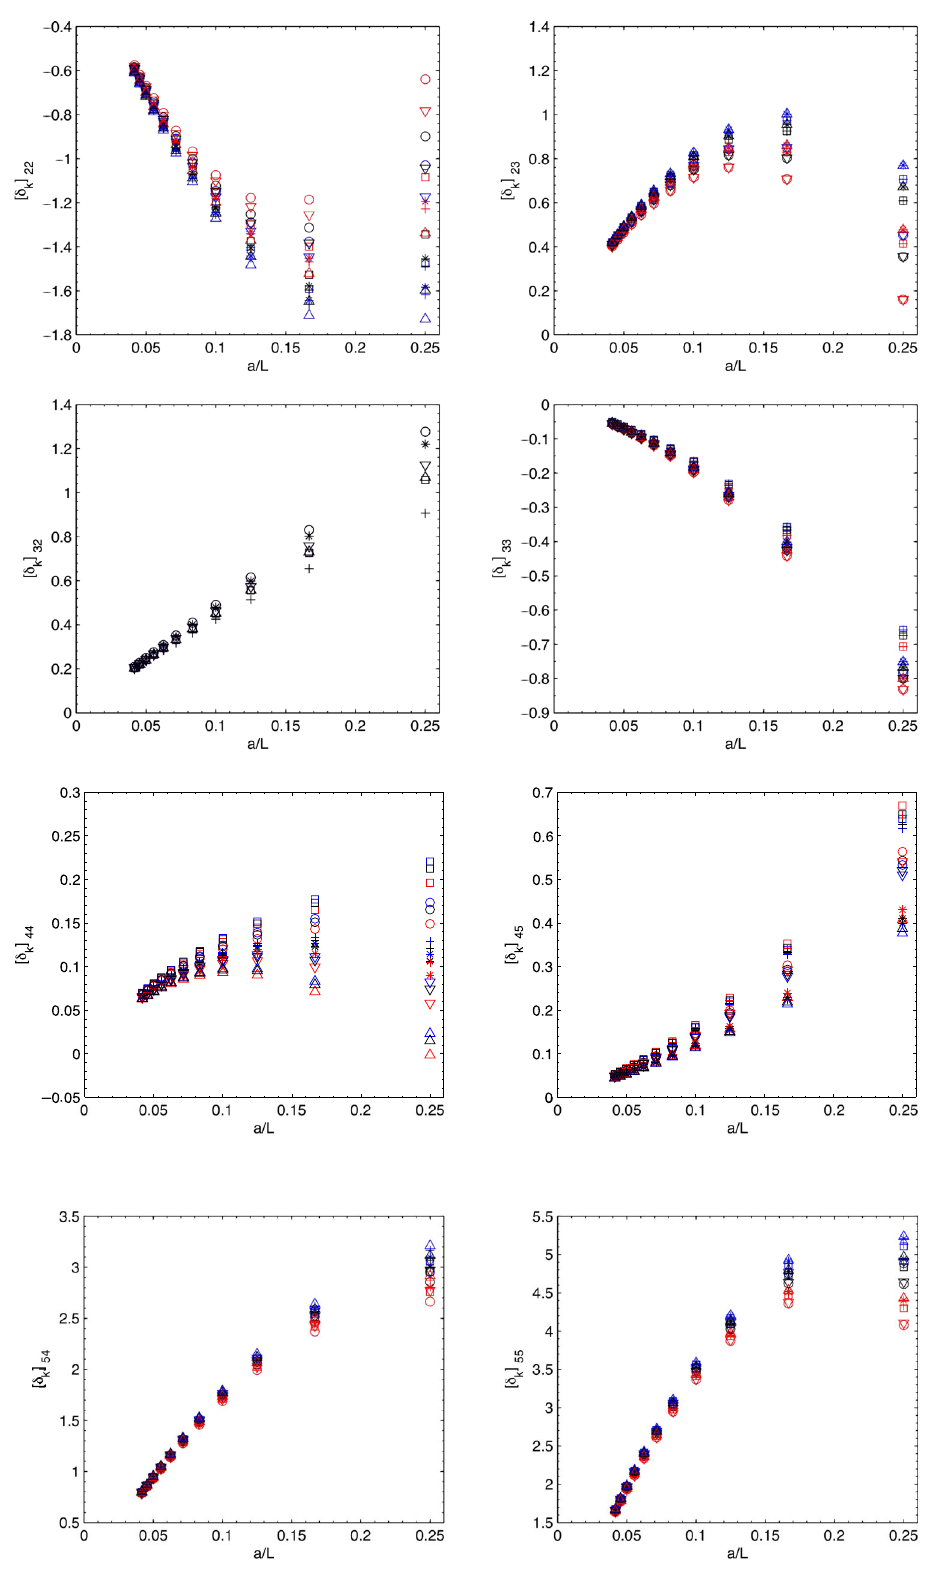
Fig. 17 Matrix elements of δ ( L / a ) with c = 0 for the k sw , Q − } (top) operator bases { Q − 2 3 , Q − } (bottom). and { Q − 4 5 Different colours distinguish the various choices of α and different symbols the various choices of ( s 1 , s 2 )